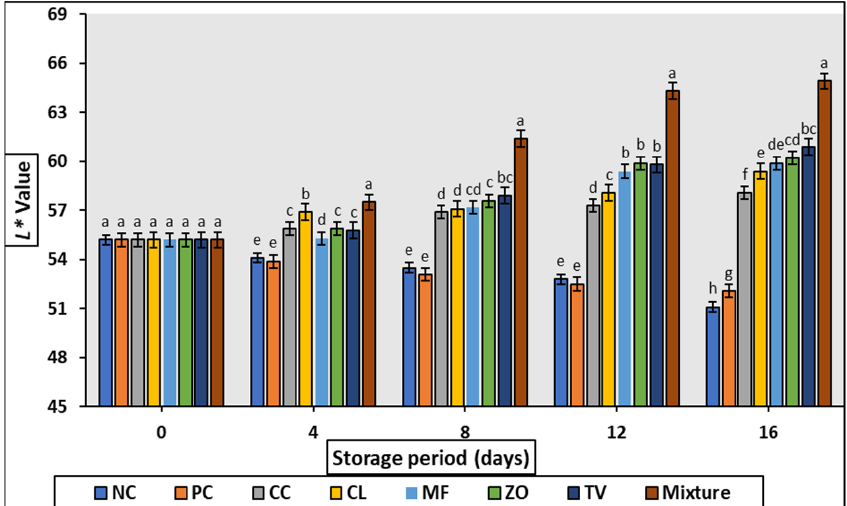
Figure 2. Changes in L* value of cold stored rabbit meat formulated with different aqueous plant extracts. Columns with different letters are significantly different ( p < 0.05).